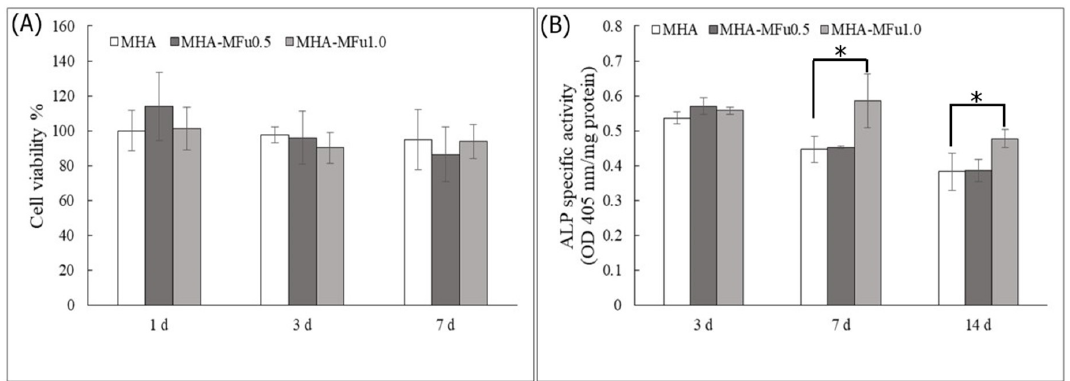
Figure 8. The cell viabilities ( A ) and ALP-specific activities ( B ) of MG63 osteoblasts on MHA and MHA-MFu hydrogels. The normalization was based on the viability of cells cultured onto MHA. * ( p < 0.05) indicates the level of significance.